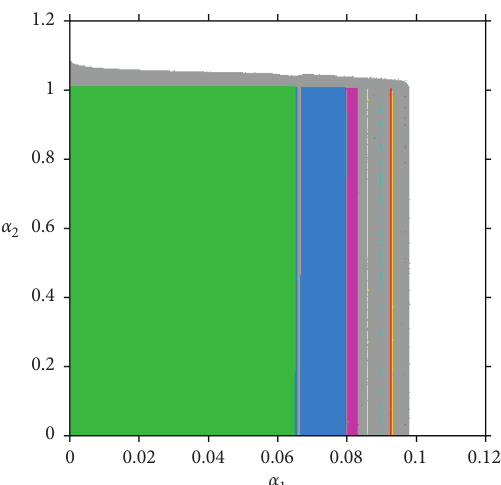
Figure 2: 2D bifurcation diagram with respect to α